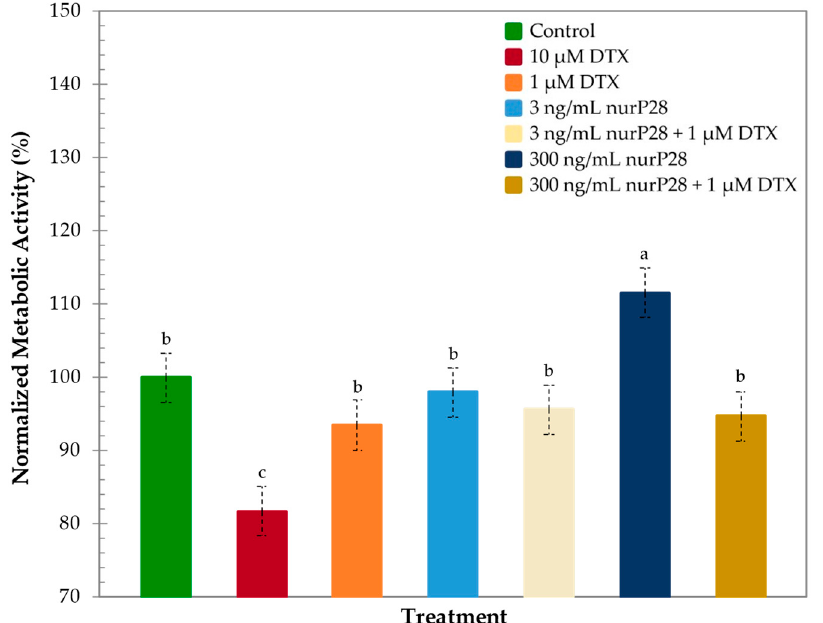
Figure 3. Normalized metabolic activity of human BJ fibroblasts after 48 h of exposure to nurP28 peptide alone and in combination with DTX. Results expressed as mean ± SD ( n = 3). The letters a, b, and c indicate a statistically significant difference at p < 0.01. Bars with no common letters are significantly different.